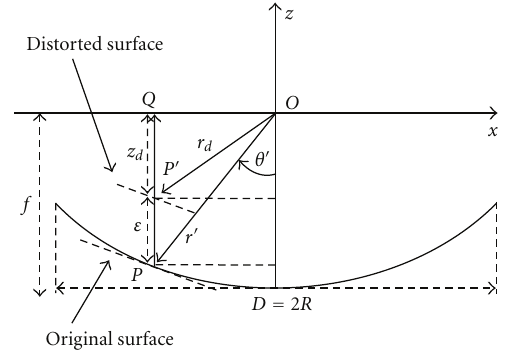
Figure 4: Description of surface